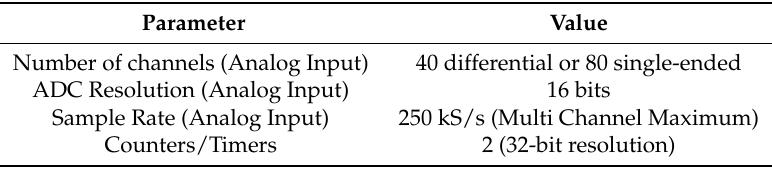
Table 6. Data Acquisition System